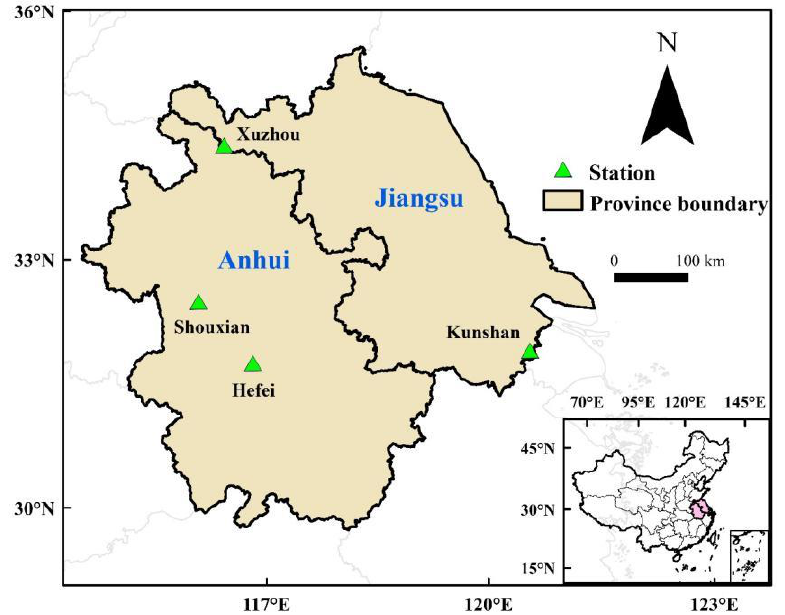
Figure 1. The spatial distribution of four selected agro-meteorological stations in the Huang-Huai-Hai Plain, China.